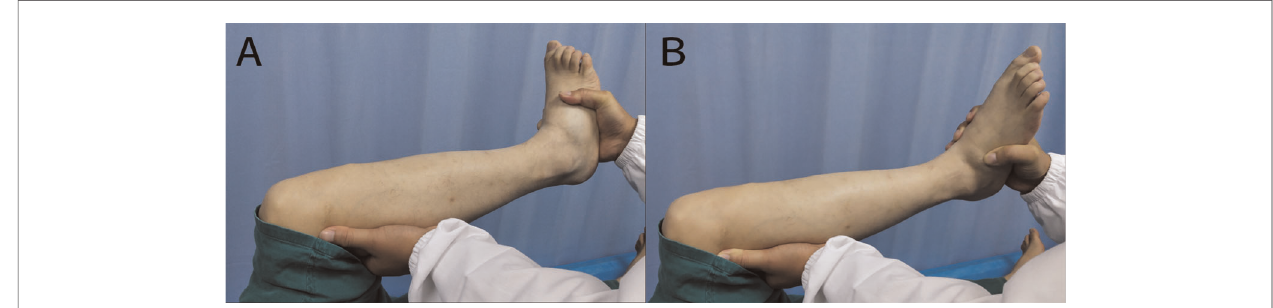
FIGURE 2 | ( A ) Garrick test (active tibial external rotation against resistance). ( B ) Passive external rotation test.